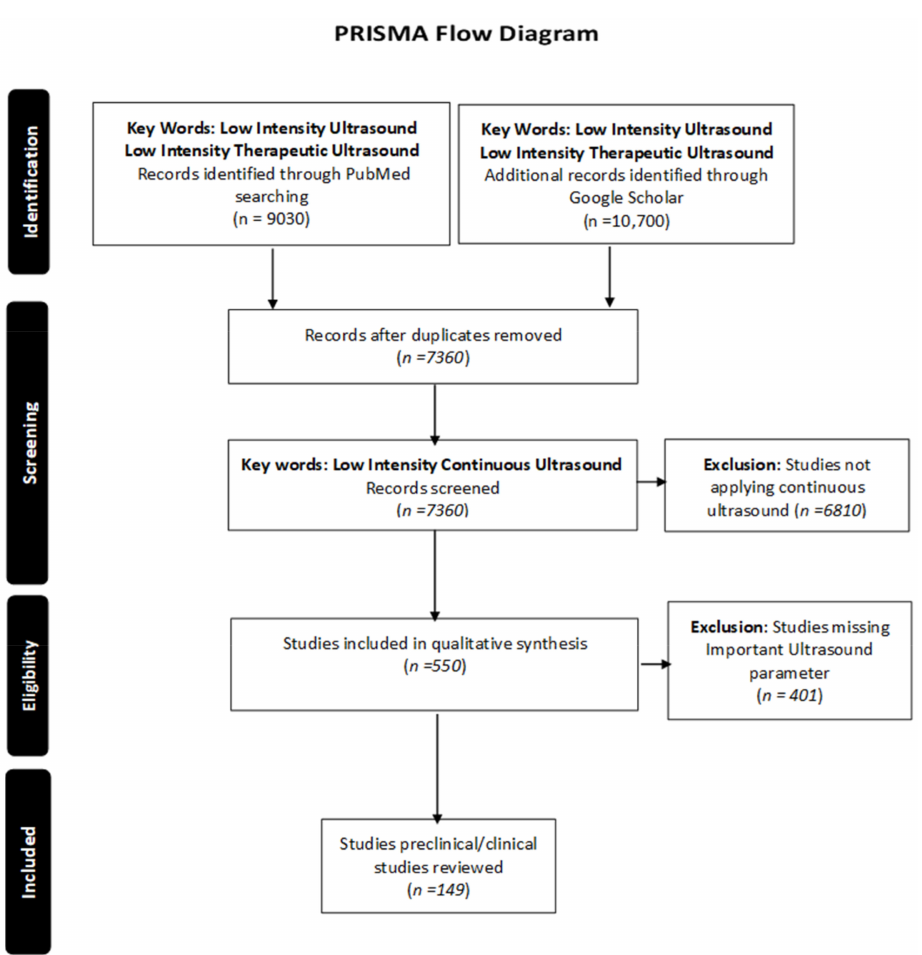
Figure 3. PRISMA flow chart: describing the methodology of article selection for